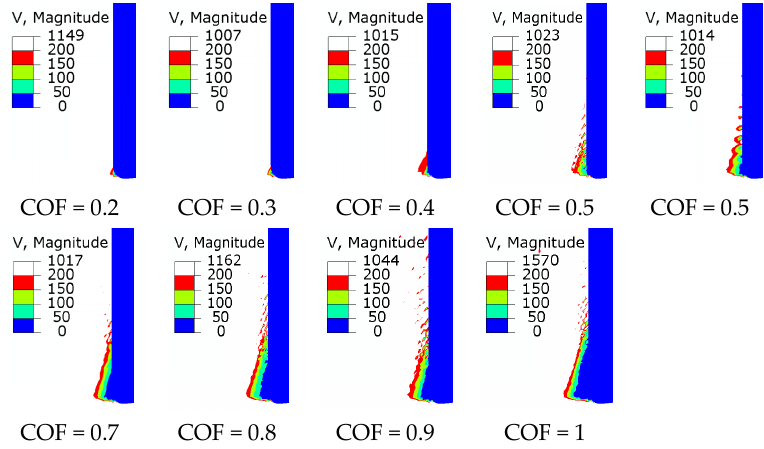
Figure 14. Effect of a gradual evolution of COF on the work material flow velocity at the tool-chip interface (increase of the sticking zone).